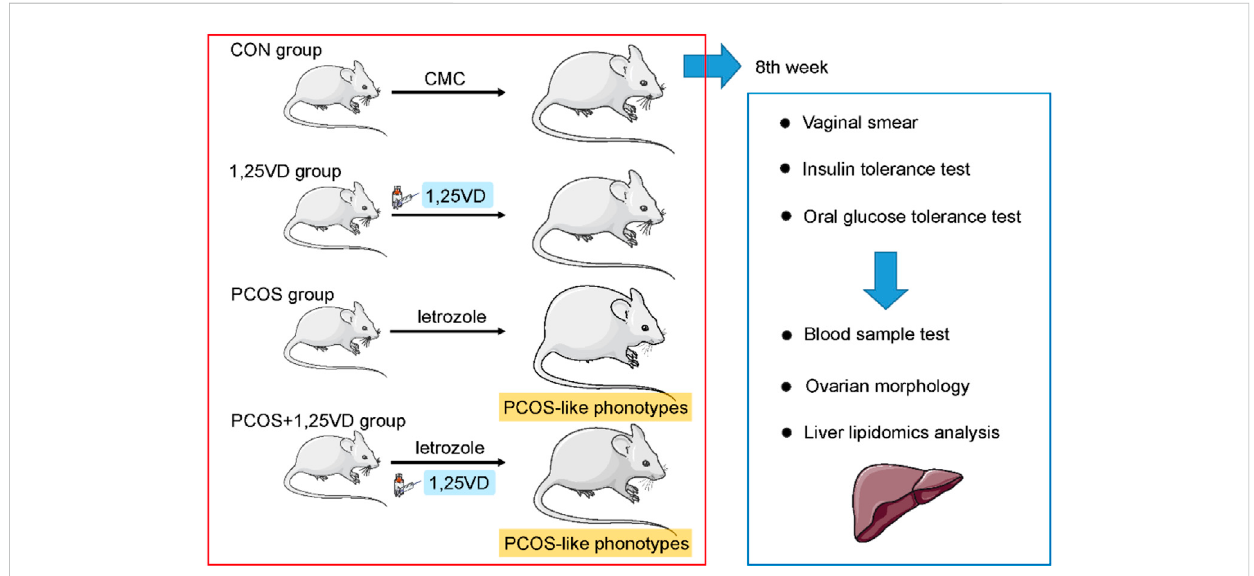
FIGURE 1 Schematic diagram of the animal study design. Rats were randomly assigned to the 1,25-dihydroxyvitamin D 3 supplementation or vehicle group. Vaginalsmear,insulintolerance testand oral glucose tolerance testwereconducted during the 8th weeks. Serum samples were collected for the evaluation of the hormone and lipid levels. Ovarian morphology was examined to verify the establishment of PCOS in the models. Hepatic samples were subjected to lipidomic pro fi